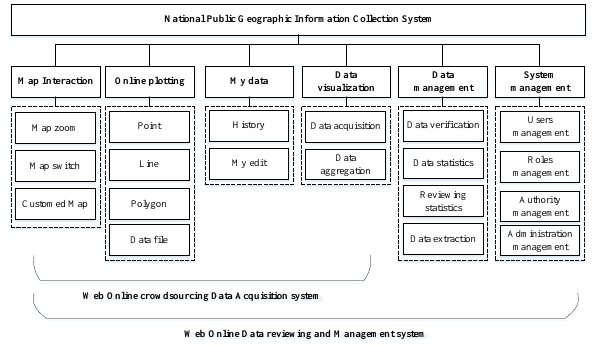
Figure 4. The functions and structure of the system